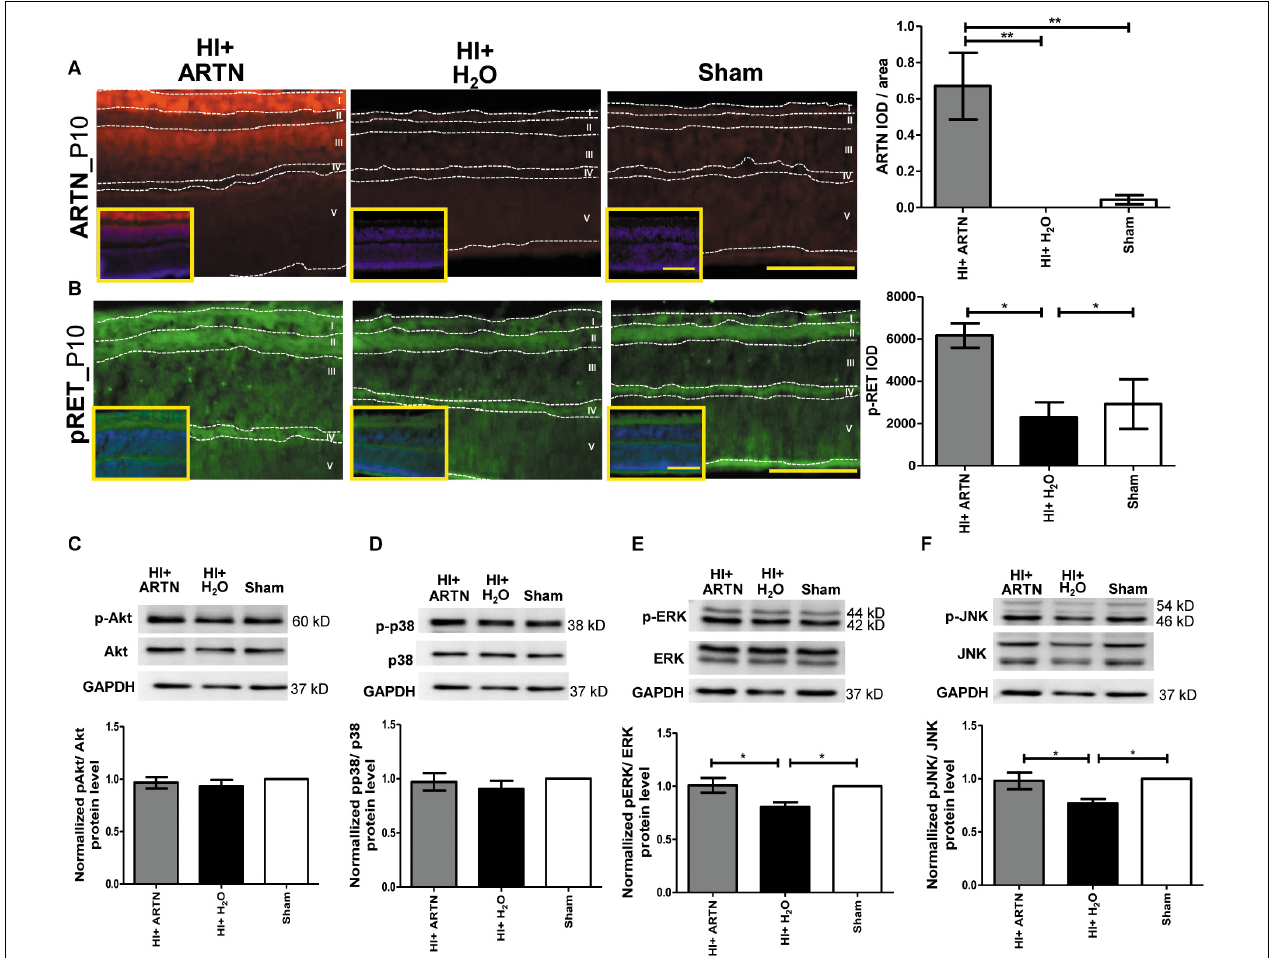
FIGURE 6 | Post-treatment with ARTN enhances RET, ERK, and JNK phosphorylation in the immature retina after HI injury. (A) At P10, the ARTN immunostaining was prominent in the retinal ganglia cells (RGC, layer I) and inner nuclear layer (INL, layer III) of the ARTN-treated HI group. The group data showed that the immunoreactivity of ARTN was significantly higher in the ARTN-treated HI group than in the H 2 O-treated HI group and the sham controls. (B) Alt P10, the immunostaining of phosphorylated RET (pRET) localized in the layers I, II (inner plexiform layer, IPL), and IV (outer plexiform layer, OPL). The group data showed that the H 2 O-treated HI group had significantly decreased pRET immunostaining as compared with the ARTN-treated HI groups and the sham controls. At P10, the western blot analysis showed there were no significant differences in the (C) phosphorylated (p) Akt or (D) pp38 among the ARTN-treated HI group, H 2 O-treated HI group, and sham controls. The ARTN-treated HI group had a higher expression of (E) pERK and (F) pJNK than the H 2 O-treated HI group. Nuclear counterstaining with DAPI (blue) was shown in the inset; layer V: outer nuclear layer (ONL); Scale bars: 100 µ m in main figures and insets; n = 4–7 per group in each time point, power = 0.8, * p < 0.05, ** p <